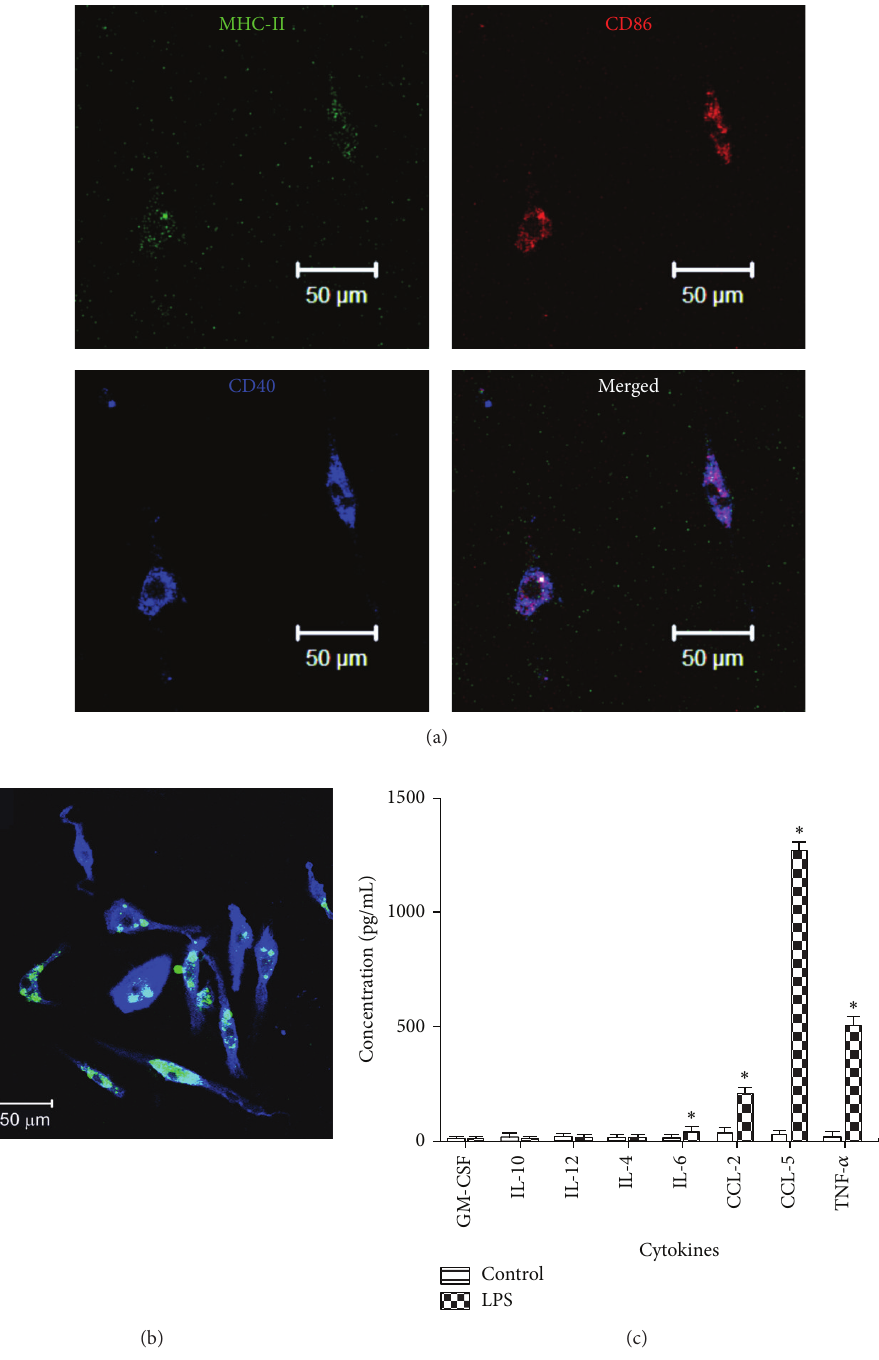
Figure 6: Immunofluorescent staining of retinal microglial cells. (a) Microglial cells were transferred into a 16-well chamber slide and stimulated with LPS in the absence of L929 supernatant for 24 h. After stimulation, cells were stained for activation markers, including MHC- II (FITC), CD86 (PE), and CD40 (APC). The slides were observed by confocal microscopy. (b) Microglial cells were transferred into a 16-well chamber slide, incubated with POS-FITC at the ratio of cells to POS-FITC 1:5 for 18 h, and stained for CD11b (APC). (c) Microglial cells (1 × 10 4 /well) were transferred into a 96-well plate and stimulated with 1 𝜇 g/mL of LPS for 24 h. The supernatant was collected and measured for the presence of IL-1 𝛽 , IL-12, IL-10, CCL2, GM-CSF, IL-6, TNF- 𝛼 , and CCL5 using CBA. ∗ 𝑃 ≤ 0.05 compared with control nonstimulated cell supernatant. Mean ± SEM, 𝑛 = 3